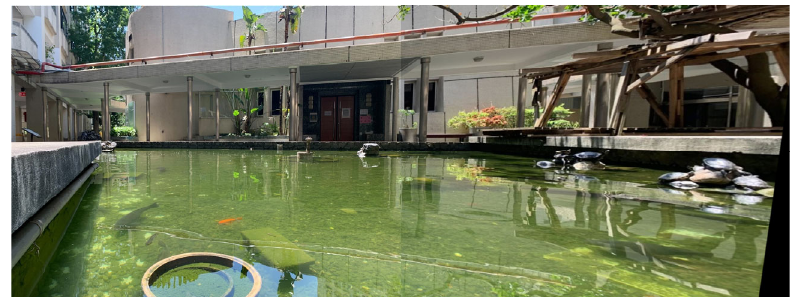
Figure 18. Final corrected wide ‐ angle image.